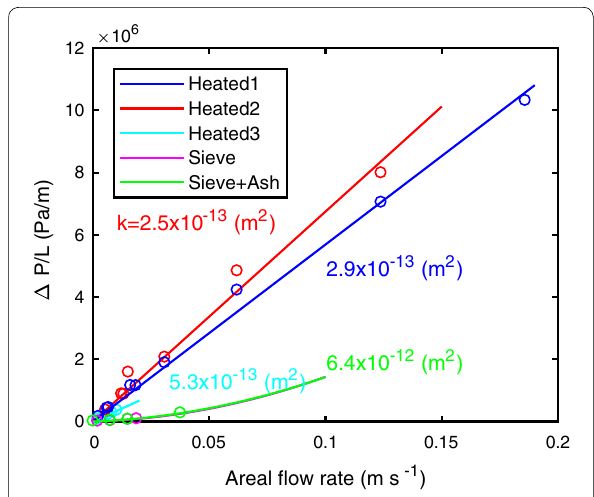
Fig. 13 Pressure gradient as a function of the flow rate per unit area. The superimposed numbers indicate the